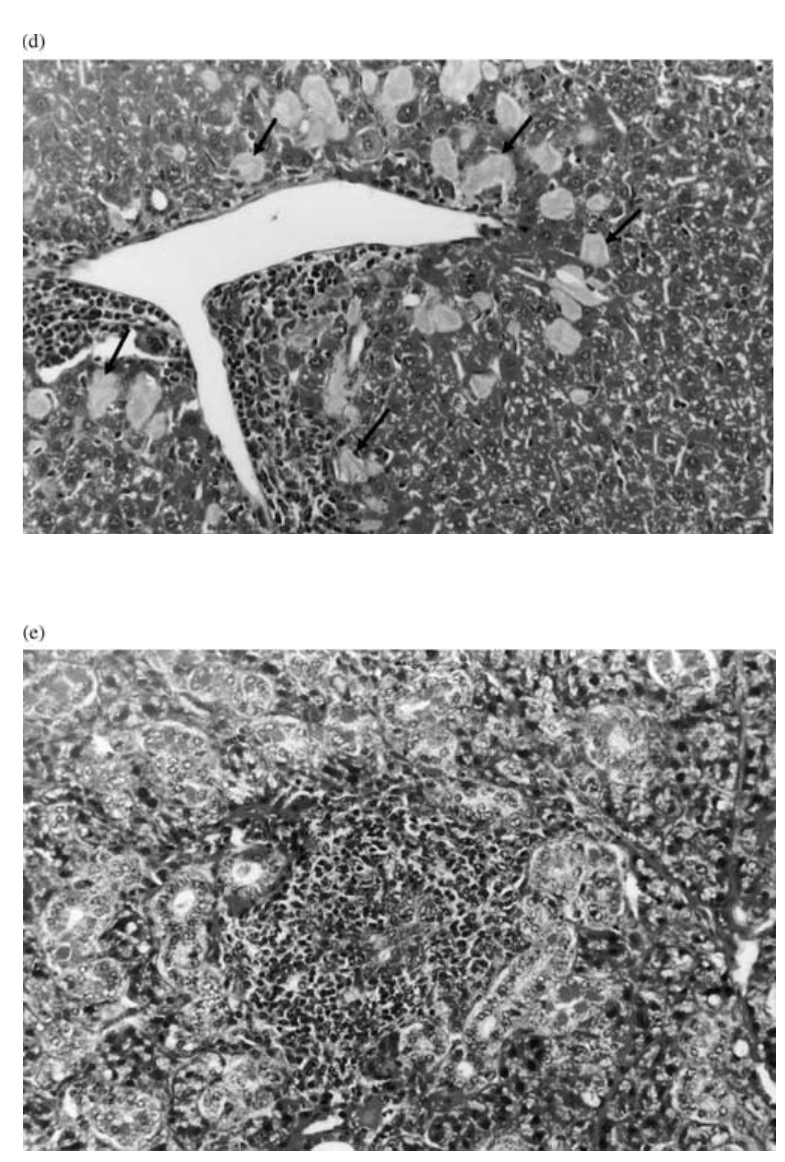
FIGURE 3 Chronic inflammation and amyloid deposition in SJL/J mice 7 and 30 weeks after immunization. (a) chronic portal infiltration and granulomas (arrows) in mice immunized with PDC-E2, 7 weeks (H&E stain, 100 £ ). (b) Chronic portal infiltration, bile duct injuries and granulomas (arrows) in mice immunized with a -casein, 7 weeks (H&E stain, 200 £ ). (c) Bile duct injuries and chronic portal infiltration in mice immunized with a -casein, 30 weeks (H&E stain, 200 £ ). (d) Amyloid deposition in the sinusoids (arrows) of mice immunized with PDC-E2 (H&E stain, 100 £ ). (e) Lymphoid cell infiltration associated with mild duct injuries in the salivary glands in mice immunized with PDC-E2 (H&E stain, 200 £